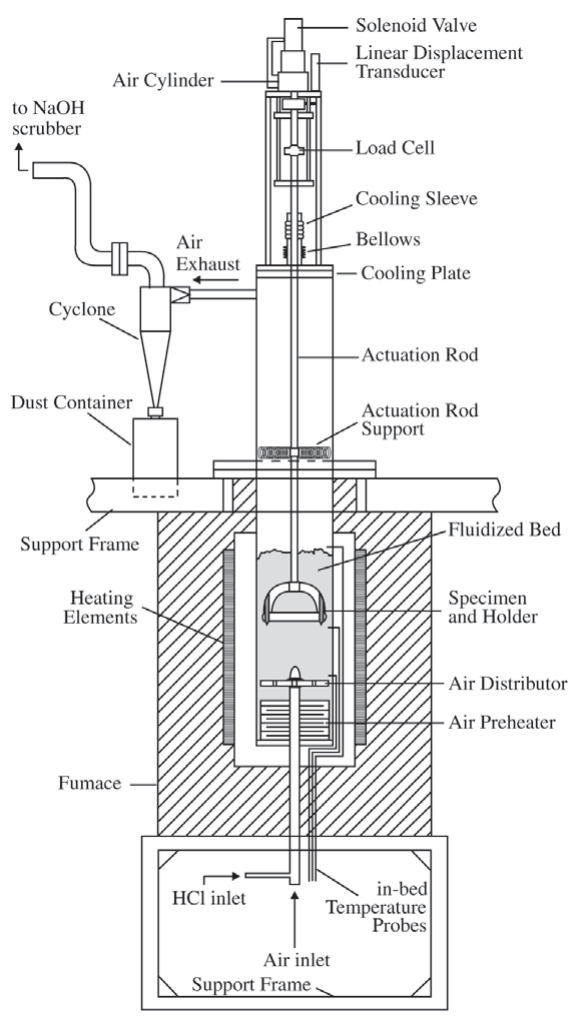
Figure 1. Schematic of the Berkeley laboratory erosion test